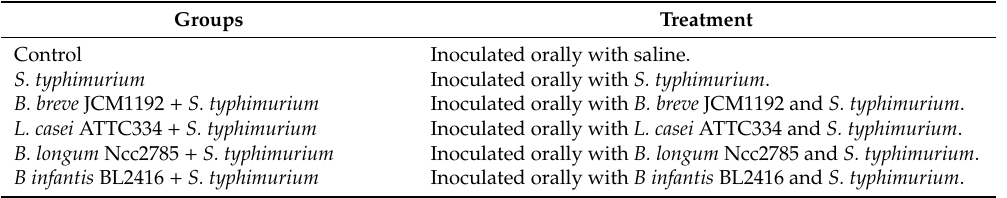
Table 2. The group of chicks treated S. typhimurium and di ff erent probiotic strains.